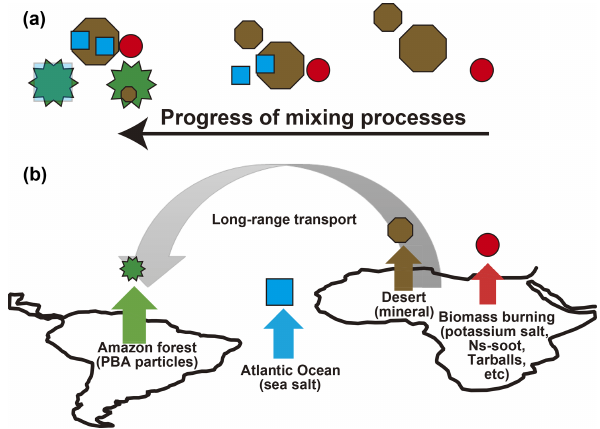
Figure 12. Schematic image of possible particle sources and trans- port pathways. Panel (a) shows the progress of individual particle mixing during LRT. Panel (b) shows possible major sources for each particle (Martin et al., 2010b).